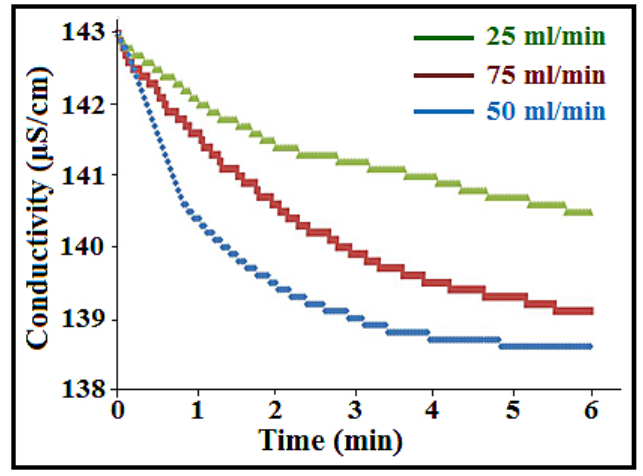
Figure 7. Conductivity variations of the NaCl solution for the 23.58 wt% a-SWCNT-coated RVC electrode as a function of operation time with respect to various flow rates (25 mL/min, 50 mL/min, and 75 mL/min) measured at 1.5